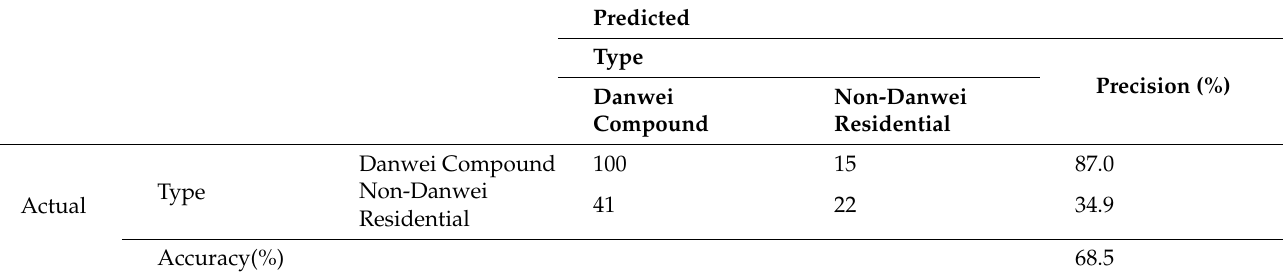
Table 5. Confusion matrix of the binary logistic regression